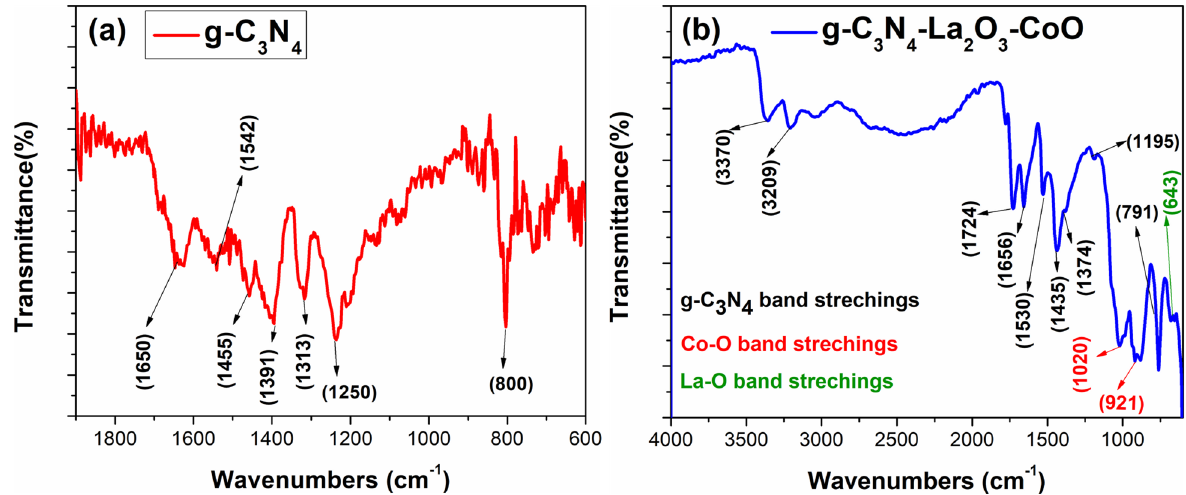
Figure 4. FTIR spectra of g-C 3 N 4 ( a ) and La 2 O 3 –CoO–g-C 3 N 4 ( b ).